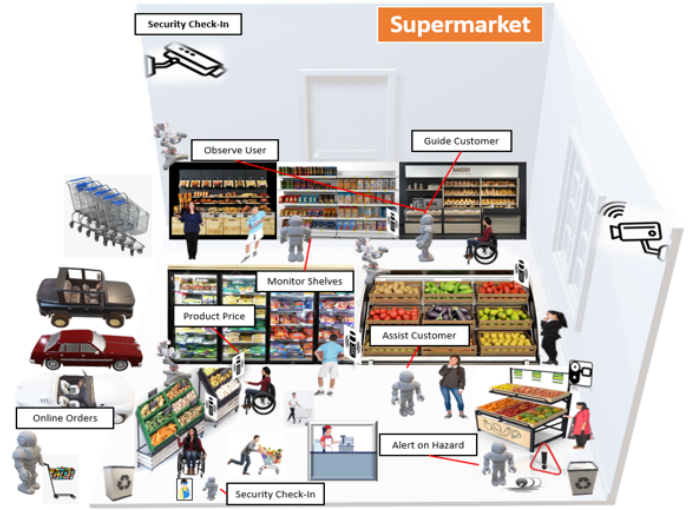
Figure 3. Supermarket domain showing an IoT collective consisting of multiple robots, smart cameras, smart speakers with customers and employees.